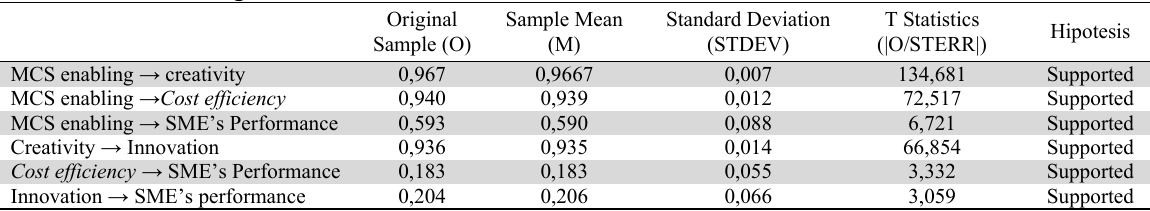
Results of Inner